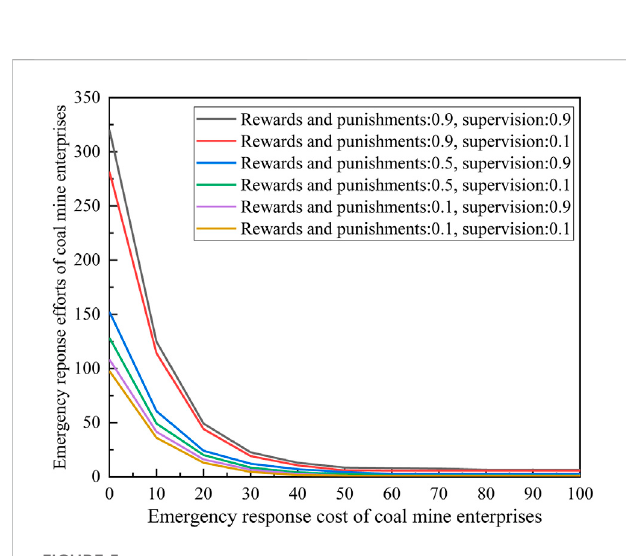
FIGURE 5 Relationship between emergency response efforts and costs of coal mining enterprises under different rewards and